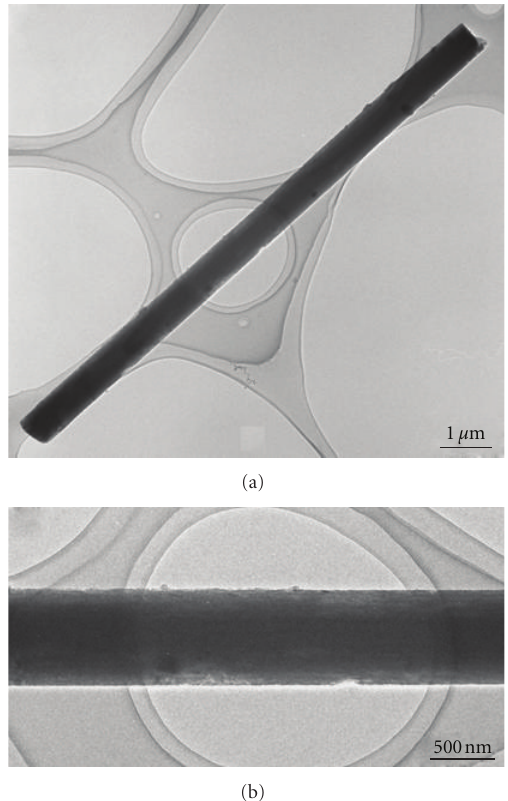
Figure 1: (a) Bright-field image of Ni-doped C 60 nanowhiskers synthesized using isopropyl alcohol with concentration of 0.01 M Ni(NO 3 ) 2 · 6H 2 O. (b) Enlarged image of (a).